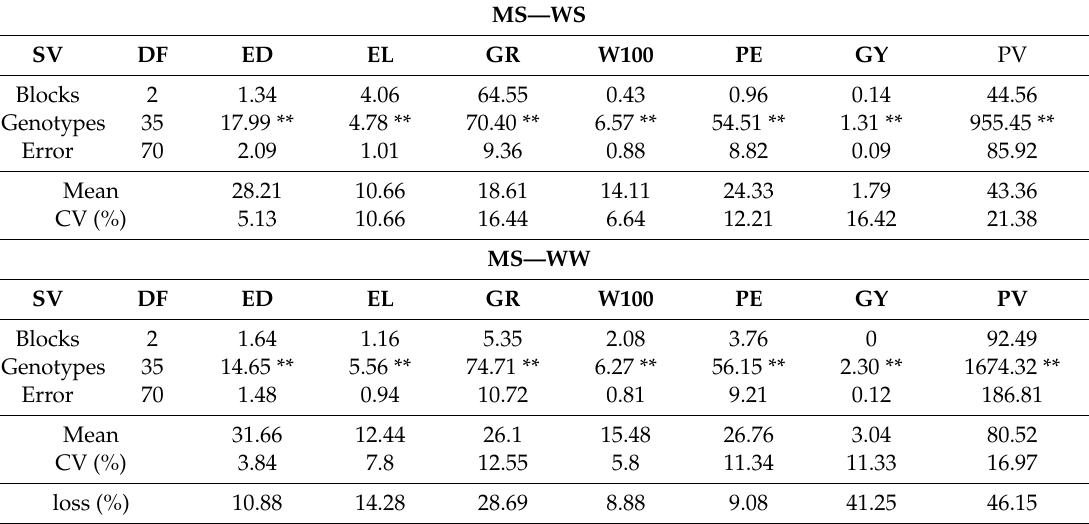
Table 2. Summary of the analysis of variance, overall means, coe ffi cient of experimental variation (CV) (%), and proportional loss (%) in a comparison of the two treatments, under water-stress (WS) and well-watered (WW)